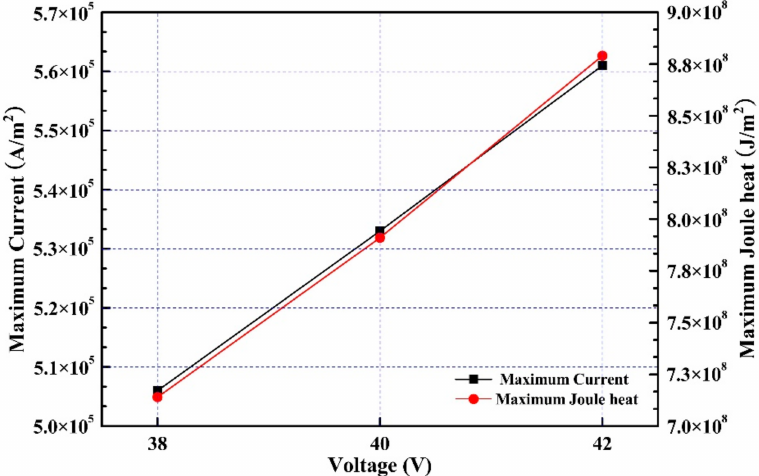
Figure 8. Evolution of the maximum current density and joule heat density of the slag